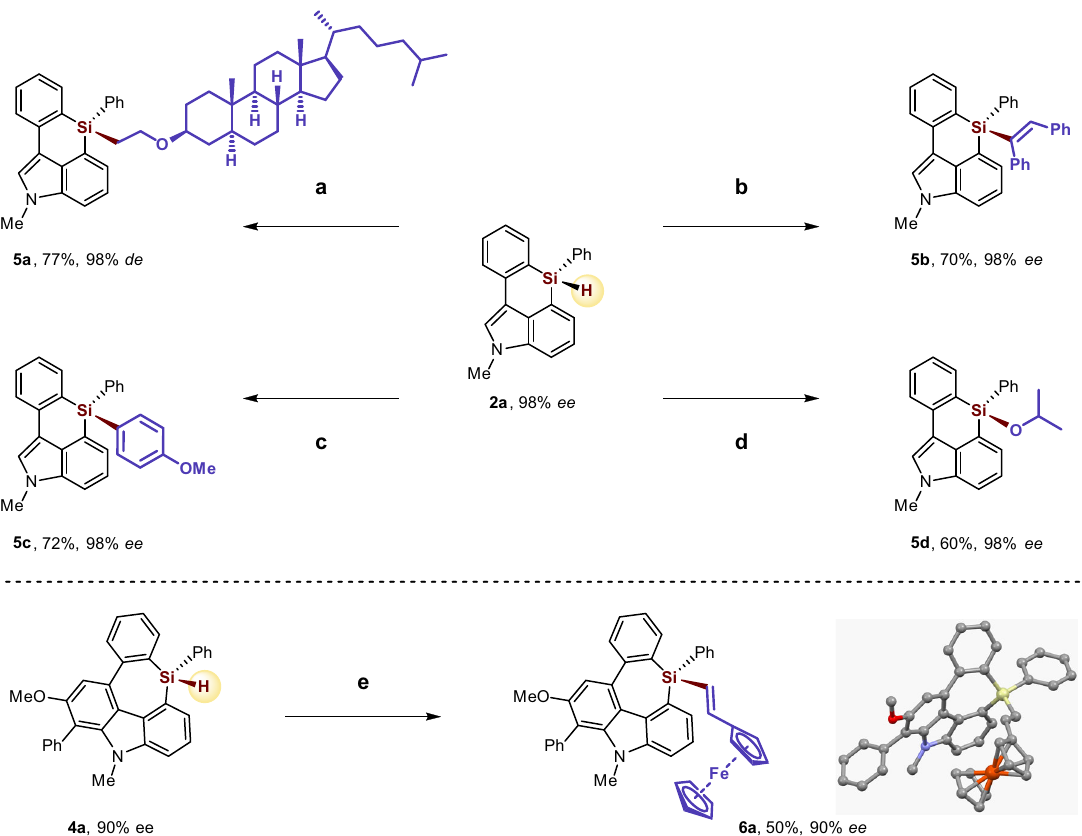
Fig. 5 Derivatization of the Si-stereogenic heterocycles. Reaction conditions: a [Rh(cod)Cl] 2 (2 mol%), ( racemic )-Josiphos L1 (4 mol%), vinyl ether (2.0 equiv), toluene, 60 °C, 12 h, de = diastereomic excess. b Pt(dvds) (10 µ L, 0.1 M in xylene), 1,2-diphenylacetylene (2.0 equiv), toluene, 40 °C, 12 h. c Pd ( t Bu 3 P) 2 (2 mol%), 4-iodoanisole (2.0 equiv), K 3 PO 4 (3.0 equiv), NMP, rt, 12 h. d [Rh(cod)Cl] 2 (2 mol%), ( racemic )-Josiphos L1 (4 mol%), acetone (2.0 equiv), toluene, 60 °C, 12 h. e [Rh(cod)Cl] 2 (2 mol%), ( racemic )-Josiphos L1 (4 mol%), vinyl ferrocene (2.0 equiv), toluene, 60 °C, 12 h.